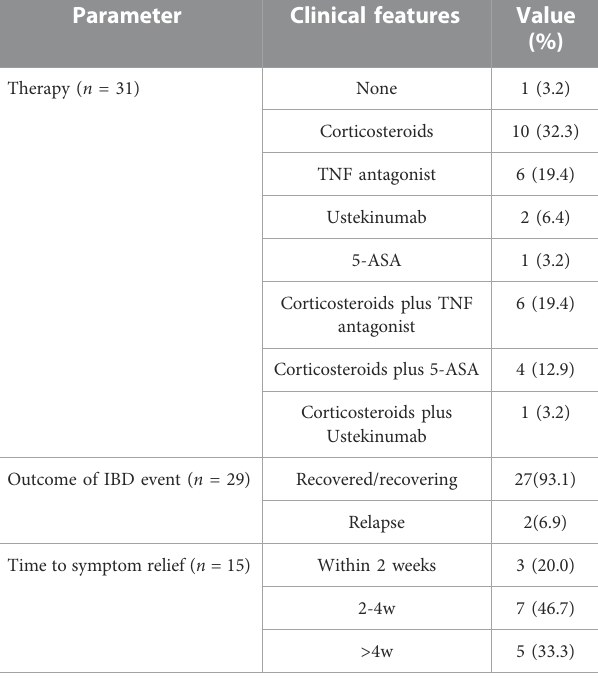
TABLE 5 Clinical information of interleukin (IL)-17 inhibitors-induced In fl ammatory bowel disease. Parameter Clinical